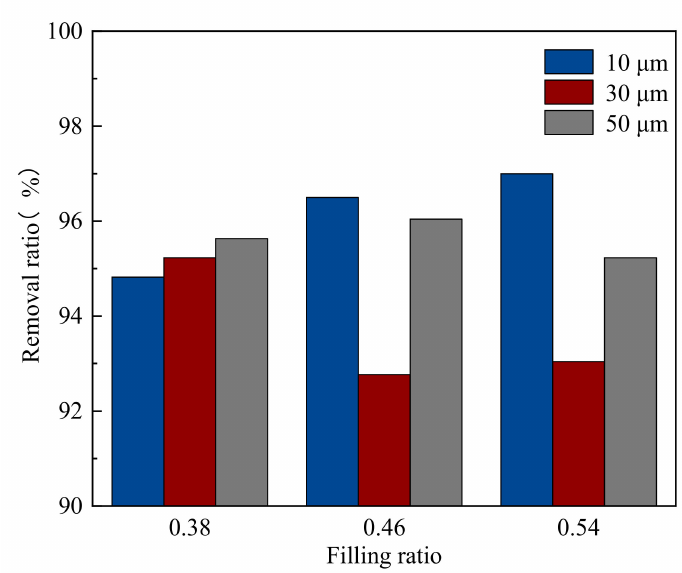
Figure 14. Effect of filling ratio on inclusions removal ratio with different